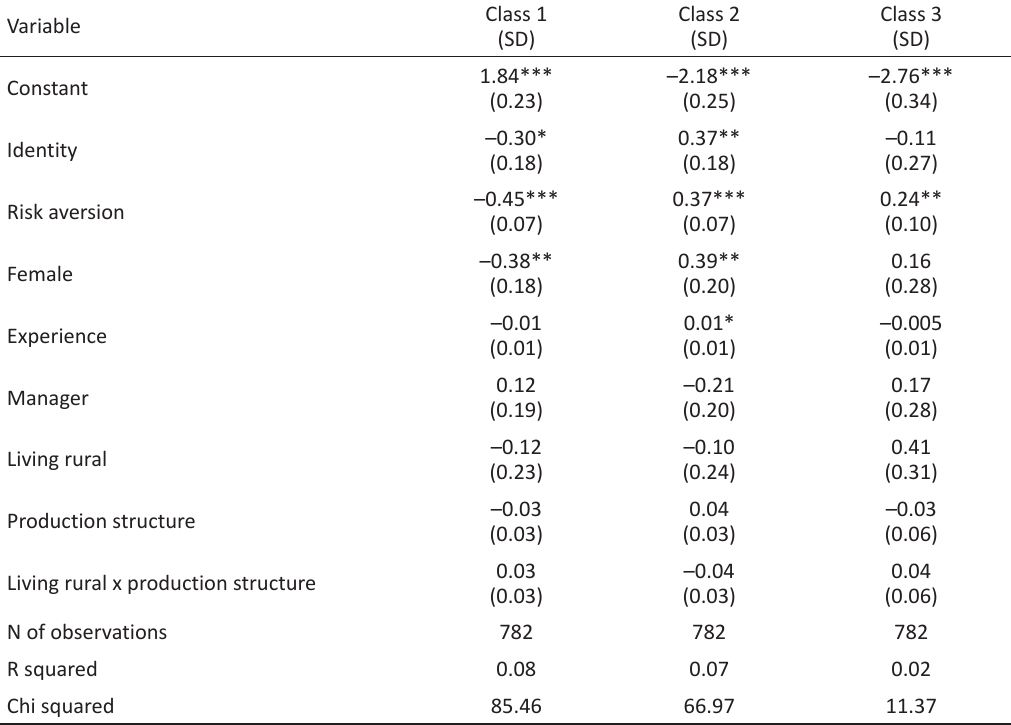
Table 4. Binary logit for investor class